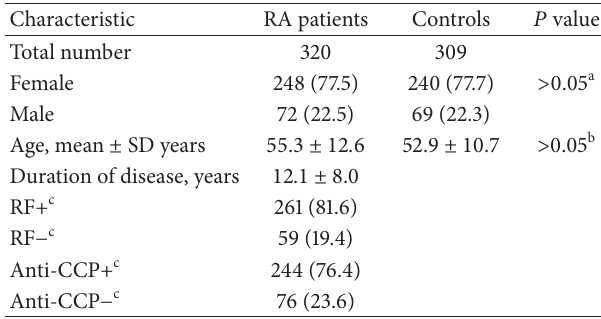
Table 1: Characteristics of RA patients and